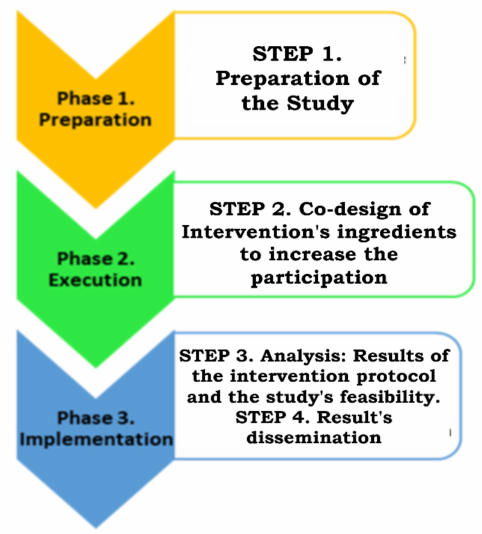
Figure 3. Research steps in the different phases of the Involvement